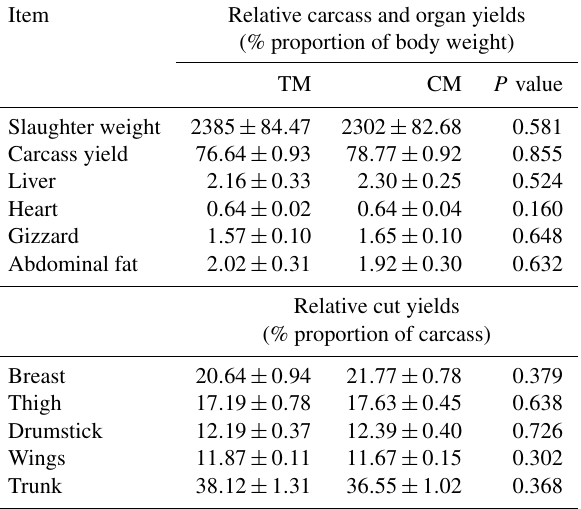
Table 3. Relative carcass, organs, and cut yields of guinea fowl in response to diets based on nutrient specifications for three- or two- phased diets (mean ±